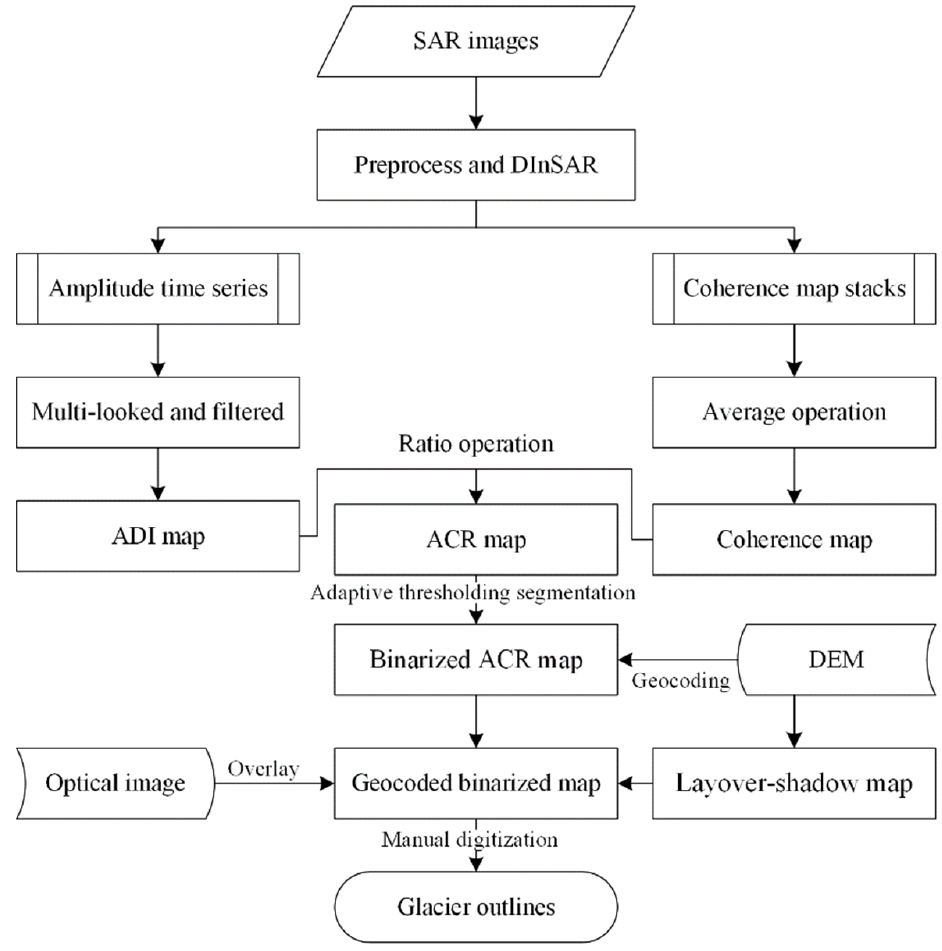
Figure 2. Data processing flow chart of the proposed method. The value of SAR coherence is influenced by several factors [31], such as geometric decorrelation, temporal decorrelation, volume decorrelation, thermal noise, ionospheric noise, and atmospheric delay. Assuming that the thermal noise, atmospheric delay, and ionospheric noise are ignored, a coherence value of 1 indicates no change in the composition of scatterers within the estimation window during the image acquisitions. The value 0 represents complete decorrelation. Owing to the rapid movement and melting of the glacier, the coherence coefficient corresponding to the glacier is generally severely decorrelated. In contrast, the coherence coefficient is generally higher for relatively stable non-glacial objects. We used the commercial GAMMA software to process the SAR images [32]. Based on the eight SAR images, we obtained 12 image pairs with a maximum time interval of 84 days and a perpendicular baseline limit of 240 m. The details of the selected InSAR pairs are shown in Table 1. We applied the multi-looking operation with six looks in the range direction and eight looks in the azimuth direction and filtered each interferogram using the adaptive Goldstein filter with a window size of 8 × 8 pixels. Finally, the coherence maps of the selected 12 InSAR image pairs calculated using Equation (1) are shown in Figure